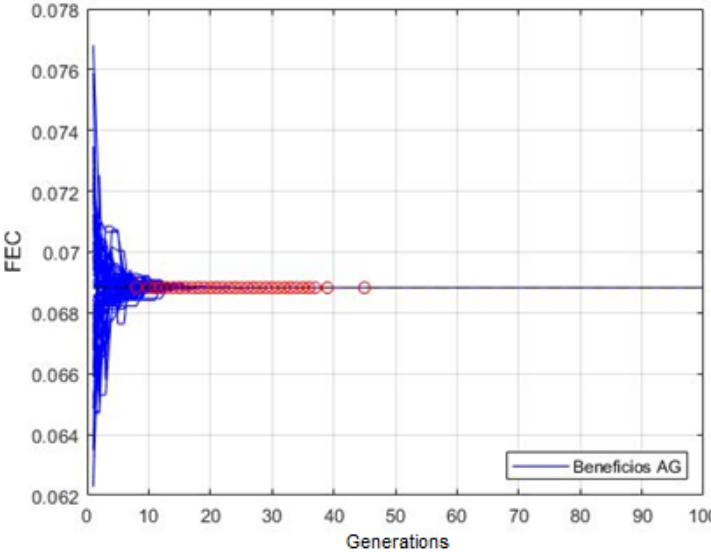
Figure 13. Average generation convergence for FEC.